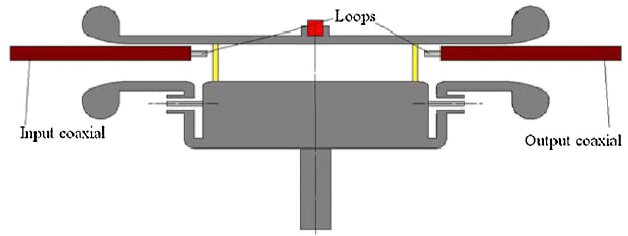
FIG. 3. An example of setup to measure FE ring loss tangent. Because of a large dielectric constant of the ceramic, modes exist with their fields almost entirely contained in the ceramic. In measurements, one may excite these modes using loops, measure their Q factors, and then in, e.g., HFSS simulations force the simulated Q factors be as the observed ones by adjusting the loss tangent of the ceramic in the simulation model which reproduces the real configuration. Hence, the value of the loss tangent is inferred for a set of frequencies corresponding to the mode spectrum.